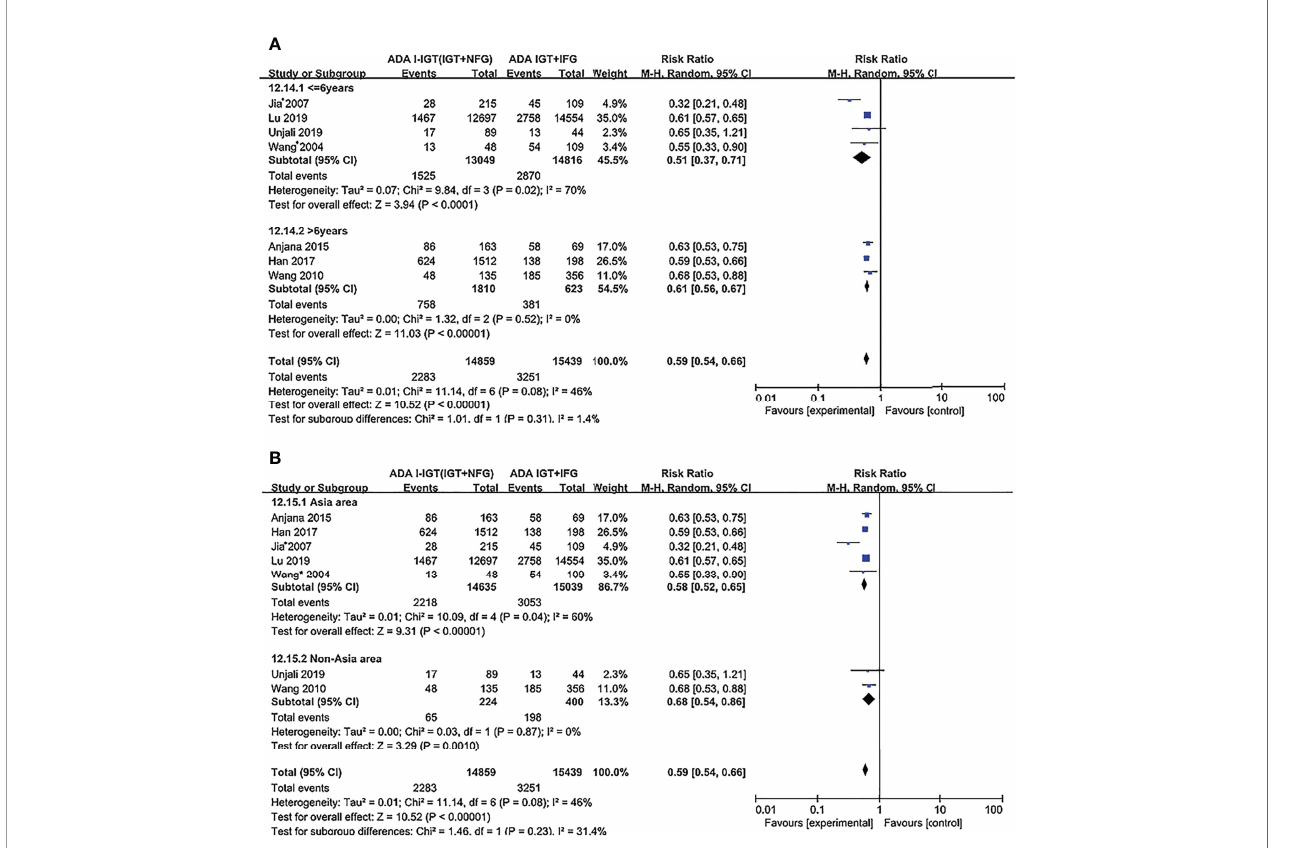
FIGURE 5 | Subgroup analysis was performed according to follow-up duration (A) and study location (B) in the ADA 2003 groups. Subgroup analysis showed that it did not affect the fi nal outcome. 95% CI, 95% con fi dence interval; I-IGT, isolated impaired glucose tolerance; IGT+IFG, impaired fasting glucose combined with impaired glucose